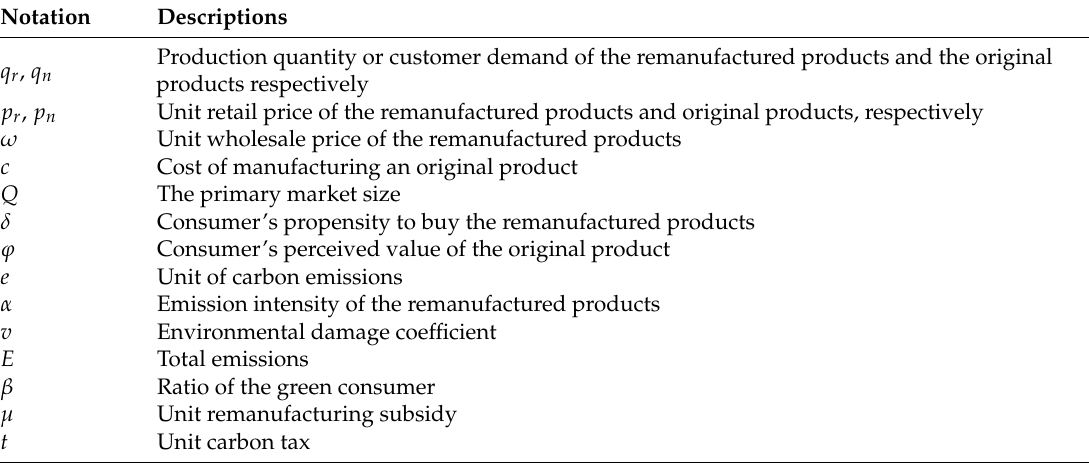
Table 1. Parameters and variables.